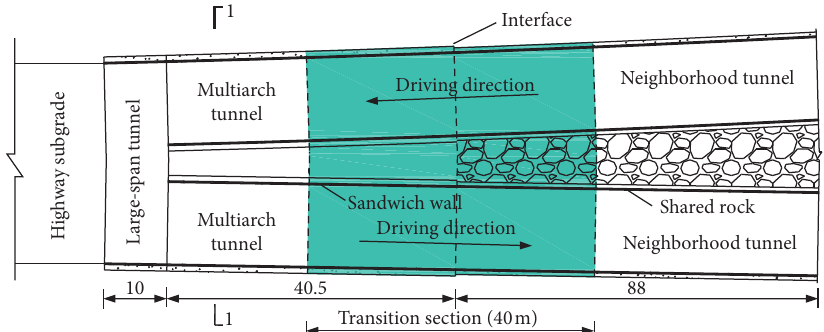
Figure 1: Plan view of the transition section of the branching-out tunnel (unit: m).